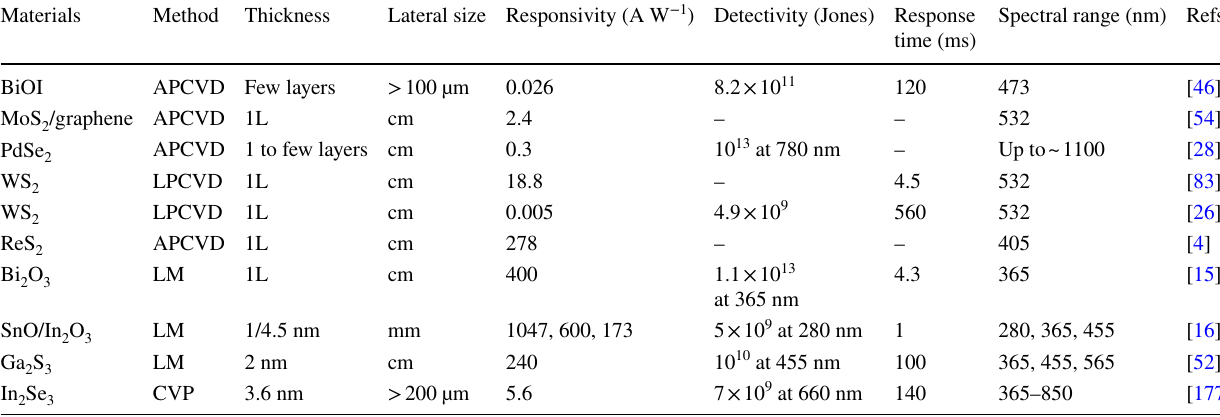
Table 2 Optoelectronic performances large-area 2D materials